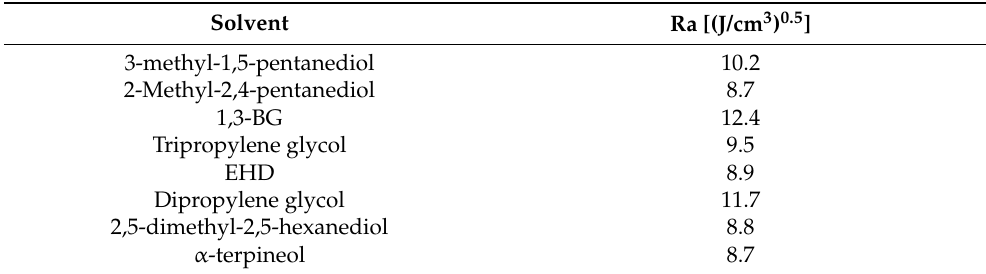
Table A3. Appropriate solvents for TIPS process and Ra of the CBzOH with the evaluated solvents (polymer concentration 25 wt%).